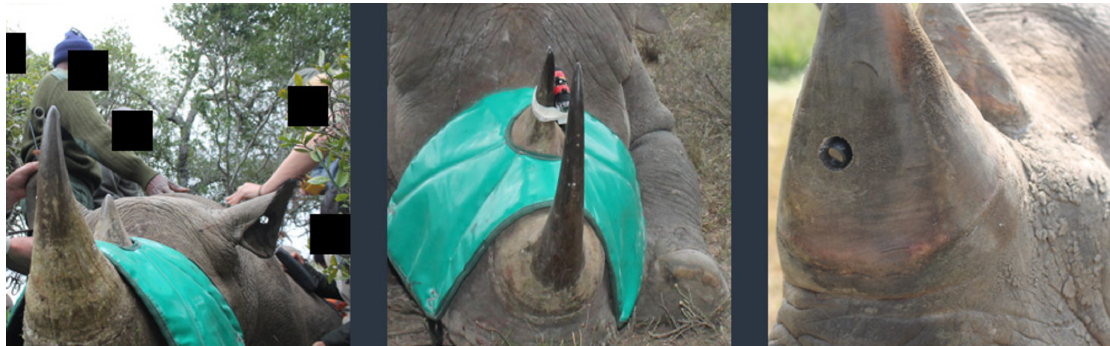
Figure 4. The camera component implanted in the front lobe of the rhino’s horn